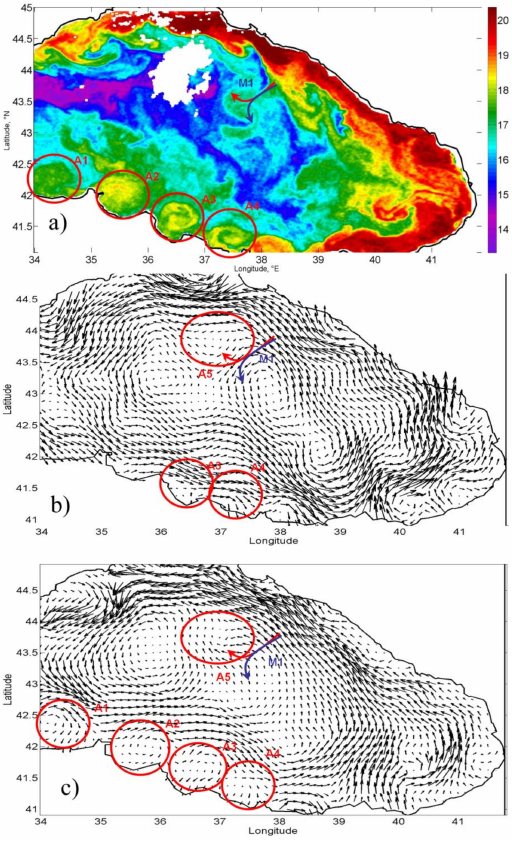
Figure 6. ( a ) AVHHR SST at 24 October 2005 00:19; ( b ) surface current calculated from altimetry; ( c ) surface current calculated from AVHHR imagery using